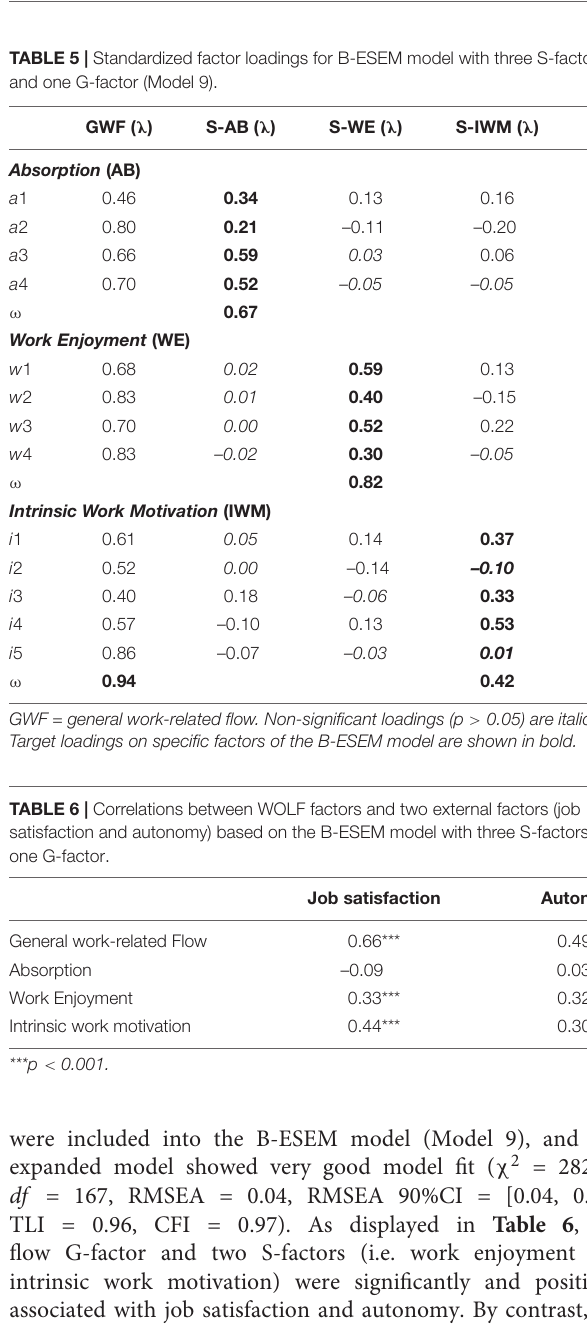
TABLE 5 | Standardized factor loadings for B-ESEM model with three S-factors and one G-factor (Model 9).